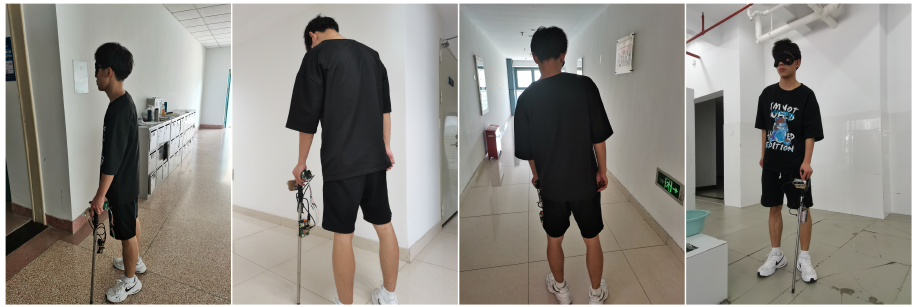
Figure 6. Example diagram of field